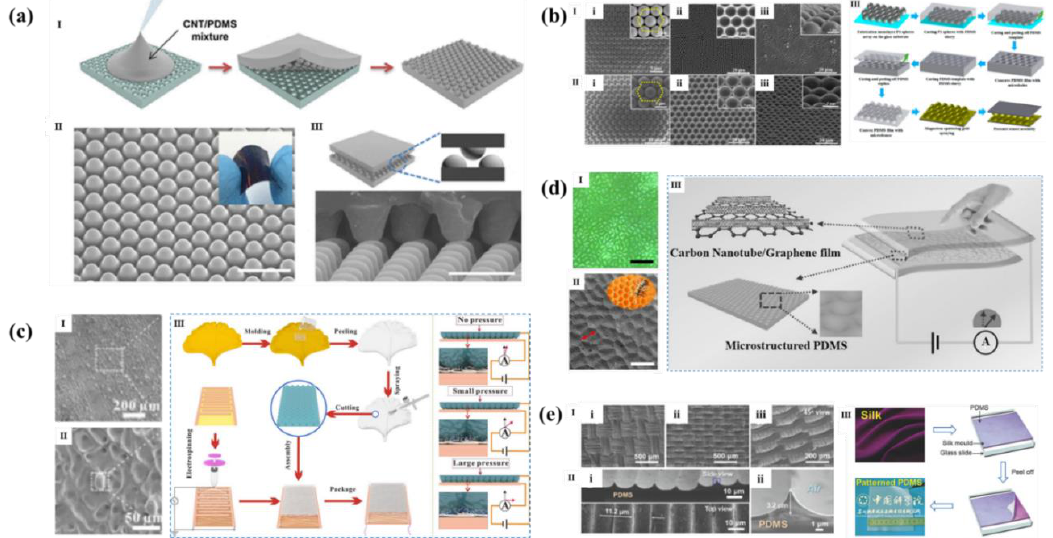
Figure 8. ( a ) Micro structured sensor with interlocking micro dome array. ( I) manufacturing process of micro dome array; ( II ) Inclined SEM image of micro dome structure; ( III ) Schematic diagram of interlocking structure (upper) and cross-sectional SEM image (lower) [41]. ( b ) Flexible pressure sensor based on micro dome. ( I ) SEM images of the monolayer PS sphere arrays fabricated by 2 µ m PS microspheres ( i ), the concave PDMS film ( ii ), and the PDMS surface with micro dome patterns ( iii ). The insets show enlarged images of the corresponding orthogonal structures; ( II ) Change the above size to 5.6 μ m; ( III ) Manufacturing process of micro dome array and flexible pressure sensor [64] ( c ). ( I – II ) SEM image of bionic ginkgo biloba leaf – like micro fluctuation structure; ( III ) schematic diagram of manufacturing process and sensing mechanism of bionic piezoresistive sensor based on MXene [65]. ( d , I ) Optical image of an epipremnum aureum leaf surface; ( II ) SEM image of m-PDMS films; ( III ) The structure of ACNT/G pressure sensor [66]. ( e , I ) SEM images of patterned ( i ) L-PDMS and ( ii ) H-PDMS films and ( iii ) 45° views of H-PDMS; ( II , i ) Top and side views of H-PDMS, ( ii ) High magnification SEM images of ( i ); ( III ) Schematic diagram of manufacturing process of flexible patterned PDMS film [67].